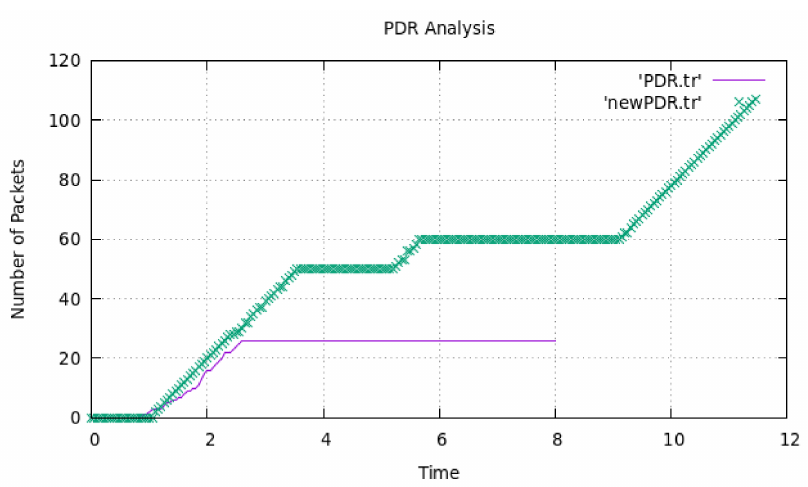
Figure 12. PDR analysis of flying